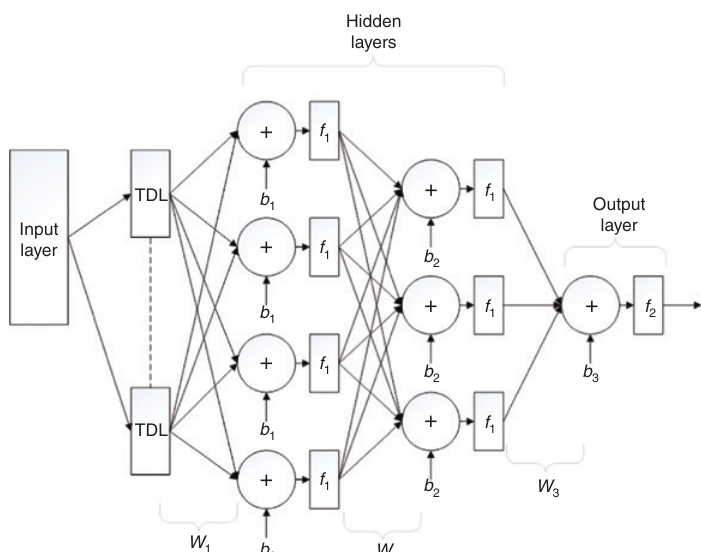
Figure 2: Generic Structure of